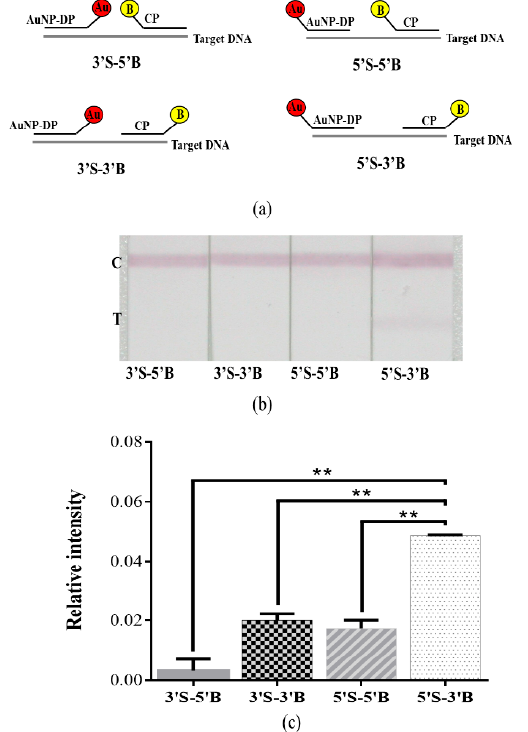
Figure 4. Effect on signal intensity from the terminus positions of thiol and biotin incorporated at the probe sequence. ( a ) Diagram of the relative positions of the termini, which had thiol and biotin attached, on the probe sequence for each combination: 3’S-5’B, 3’S-3’B, 5’S-5’B, and 5’S-3’B. ( b ) Photographic images of the detection of BKV target DNA by the developed lateral flow strip. ( c ) Relative intensity analyses of ( b ). The ** p < 0.01; data are presented as the mean and SD.